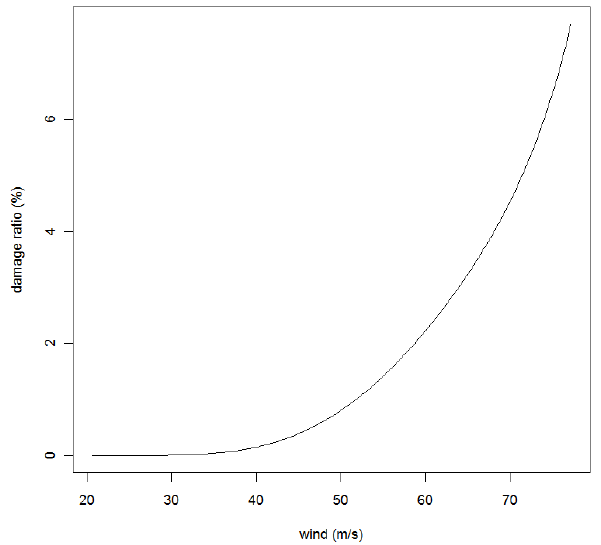
Fig. 4 Value-weighted mean transfer function to map wind speed to damage ratio. Fig. 4. Value-weighted mean transfer function to map wind speed to damage ratio.